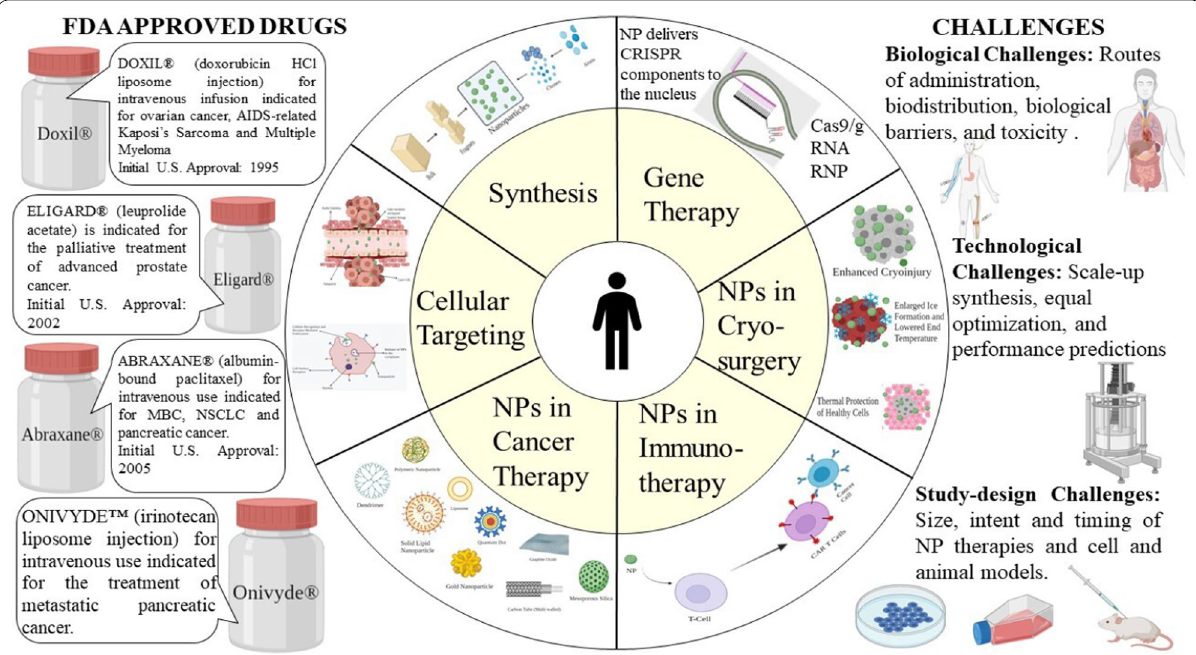
Fig. 1 Nanoparticles for cancer